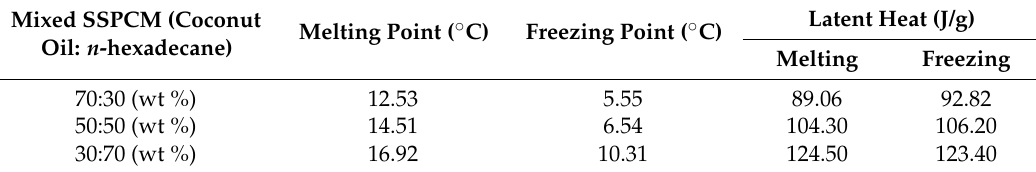
Figure 4. Differential scanning calorimetry (DSC) graphs of Mixed SSPCMs. Table 4. DSC analysis of Mixed SSPCMs.